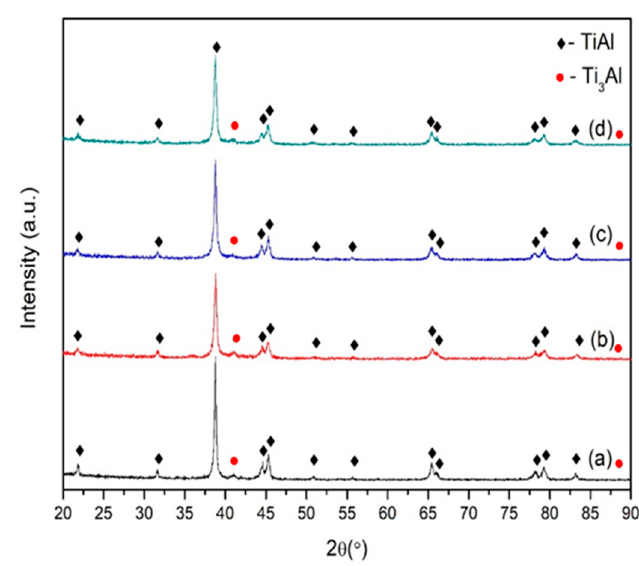
Figure 3. XRD spectra of ( a ) Ti-48Al-2Cr-2Nb + 0% Mn, ( b ) Ti-48Al-2Cr-2Nb + 2.5% Mn, ( c ) Ti-48Al-2Cr-2Nb + 5% Mn, and ( d ) Ti-48Al-2Cr-2Nb + 7.5% Mn.